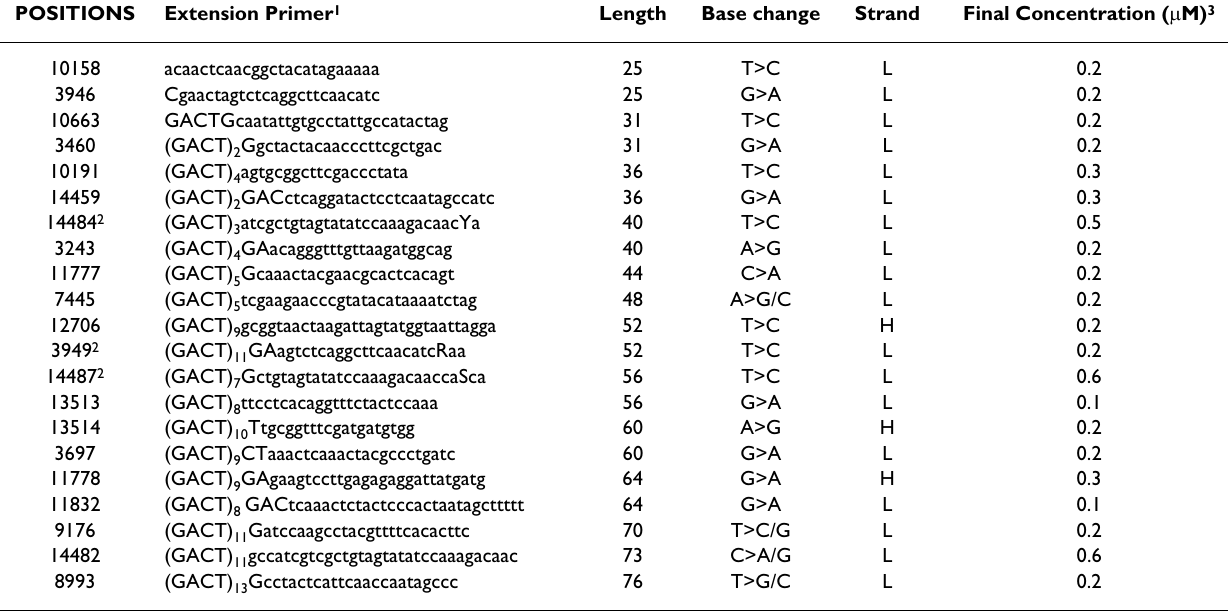
Table 3: Minisequencing primers POSITIONS Extension Primer 1 Length Base change